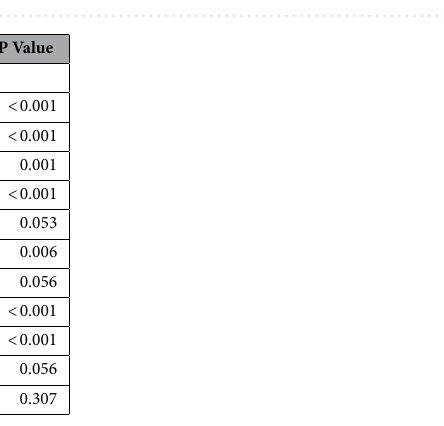
Figure 2. Adjusted odds ratios (ORs) of symptomatic venous thromboembolism with increased number of transfusions versus no transfusion in the primary cohort ( a ) and revision cohort ( b ). *Bars reflecting 95% confidence interval.